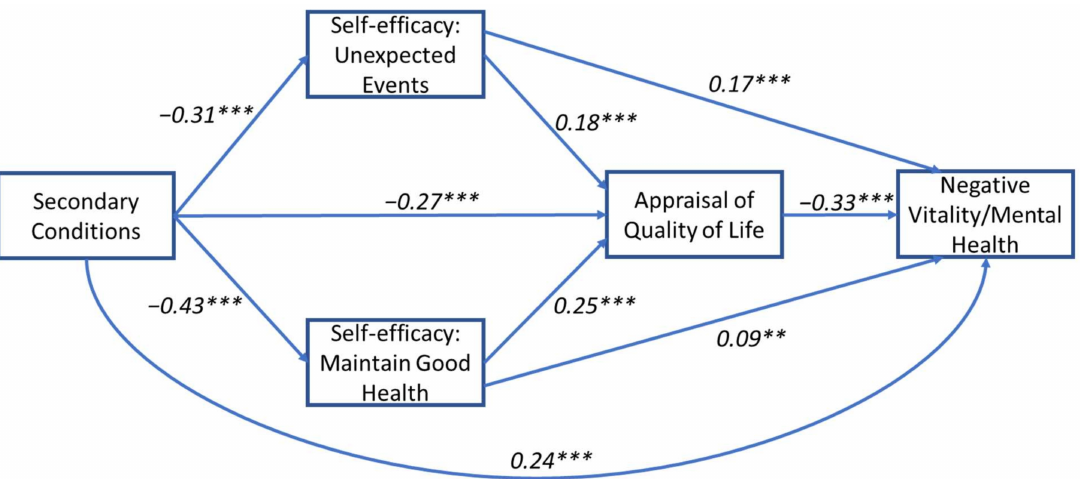
Figure 6. Mediation path model for the relationship between secondary conditions and negative vitality/mental health. Standardised regression coefficients ( β ) are presented for the direct paths. Model includes two parallel self-efficacy mediators (unexpected events and maintain good health) that are serially antecedent to a third mediator (self-appraisal of quality of life). Model is adjusted for age, sex, time since injury, and injury level. *** p < 0.001, ** p <